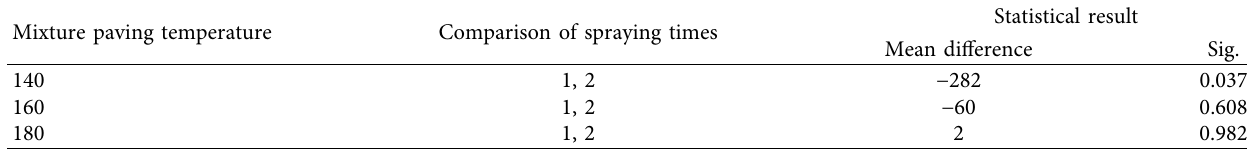
Table 7: Student’s t -test results for the influence of tack coat spraying times.